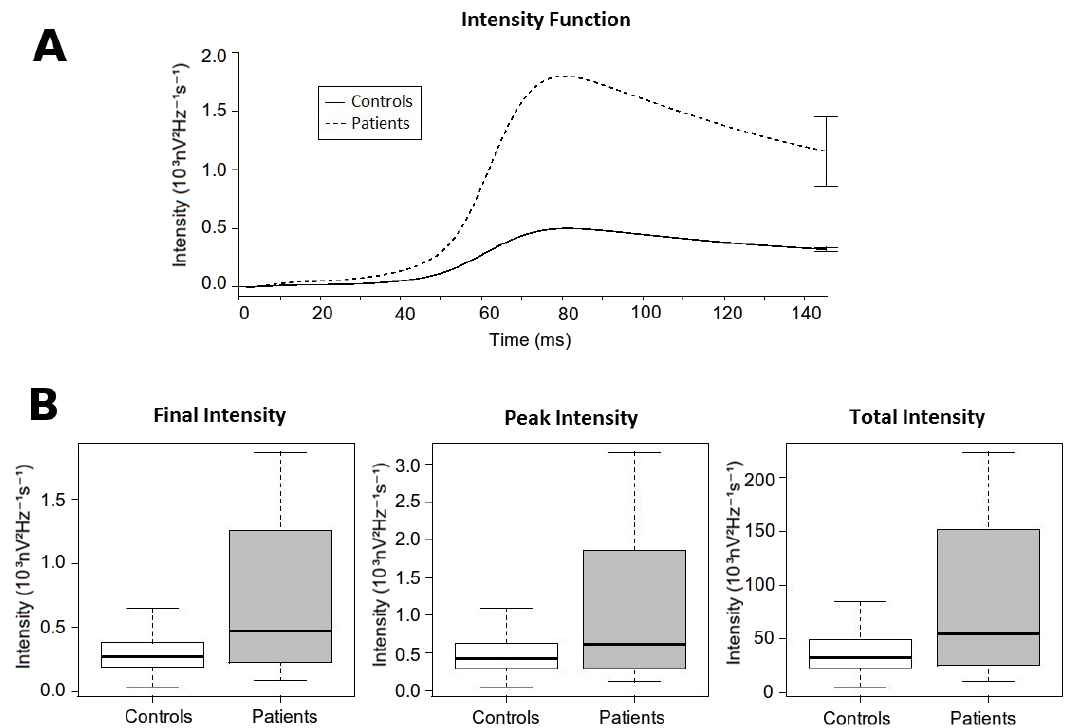
Figure 6. Intensity analysis. ( A ) Intensity function. It shows the value of the intensity function for each group in each time epoch. The final error bars represent the Final Intensity with its standard error for each group. ( B ) Boxplot comparing different measures of the intensity function between both groups. From left to right: Final intensity , Peak intensity and Total Intensity.